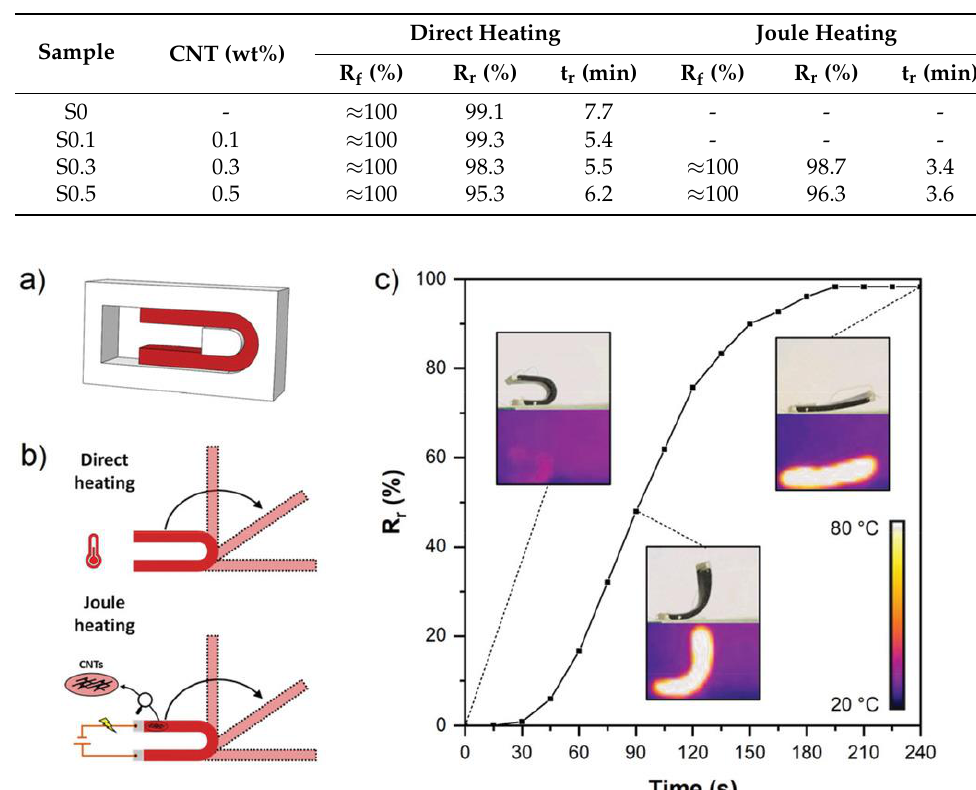
Figure 22. ( a ) DLP-printed mould to fix the U shape of CNT/methacrylate components; ( b ) direct heating and Joule heating to trigger the shape recovery; and ( c ) shape recovery under Joule heating using a thermal camera [139].